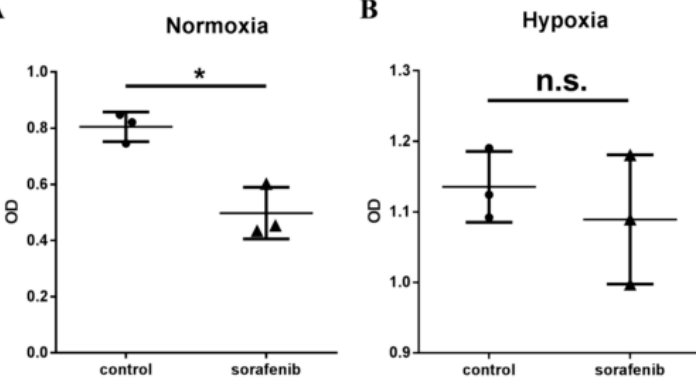
Figure 2. Hypoxia inhibited the effect of sorafenib on proliferation of human HCC cells.SNU-761 cells were serum starved for 16 h and then treated with sorafenib (8 μ M) in the presence or absence of 3- BP (75 μ M). Cell growth was determined using the MTS assay under ( A ) normoxic and ( B ) hypoxic conditions ( n = 3, Mann-Whitney test, * p < 0.005 (0.0074)).